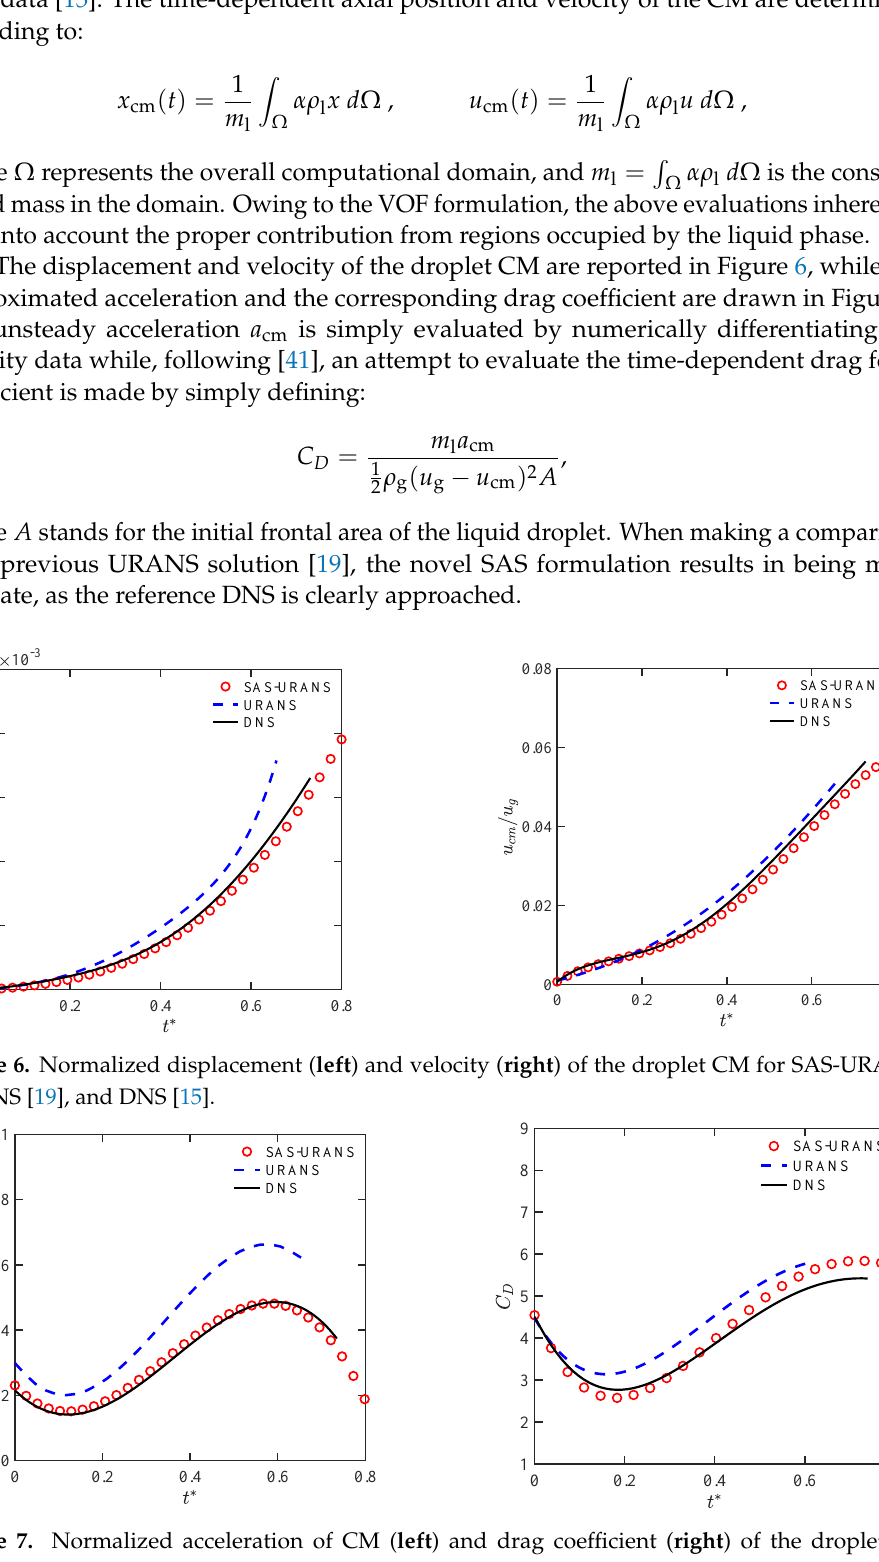
Figure 7. Normalized acceleration of CM ( left ) and drag coefficient ( right ) of the droplet for SAS-URANS, URANS [19], and DNS